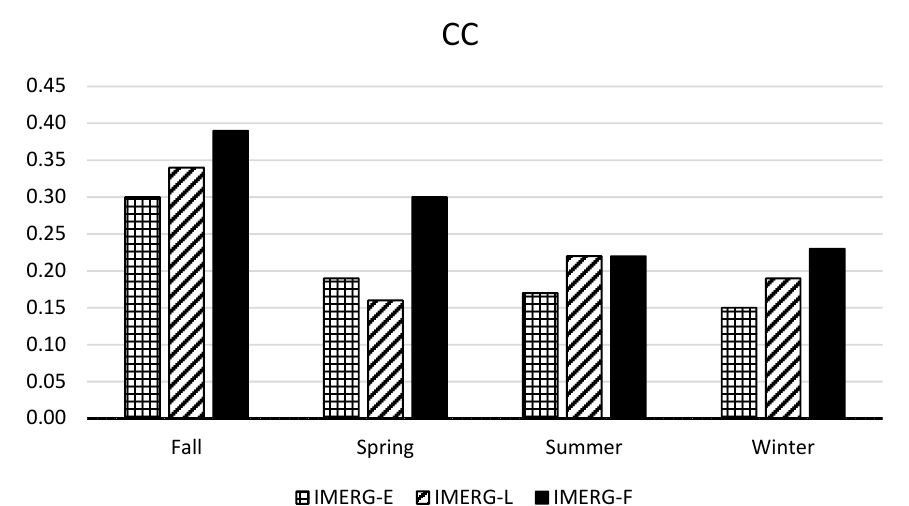
Figure 4. POD values for each season based on the seasonal evaluation.